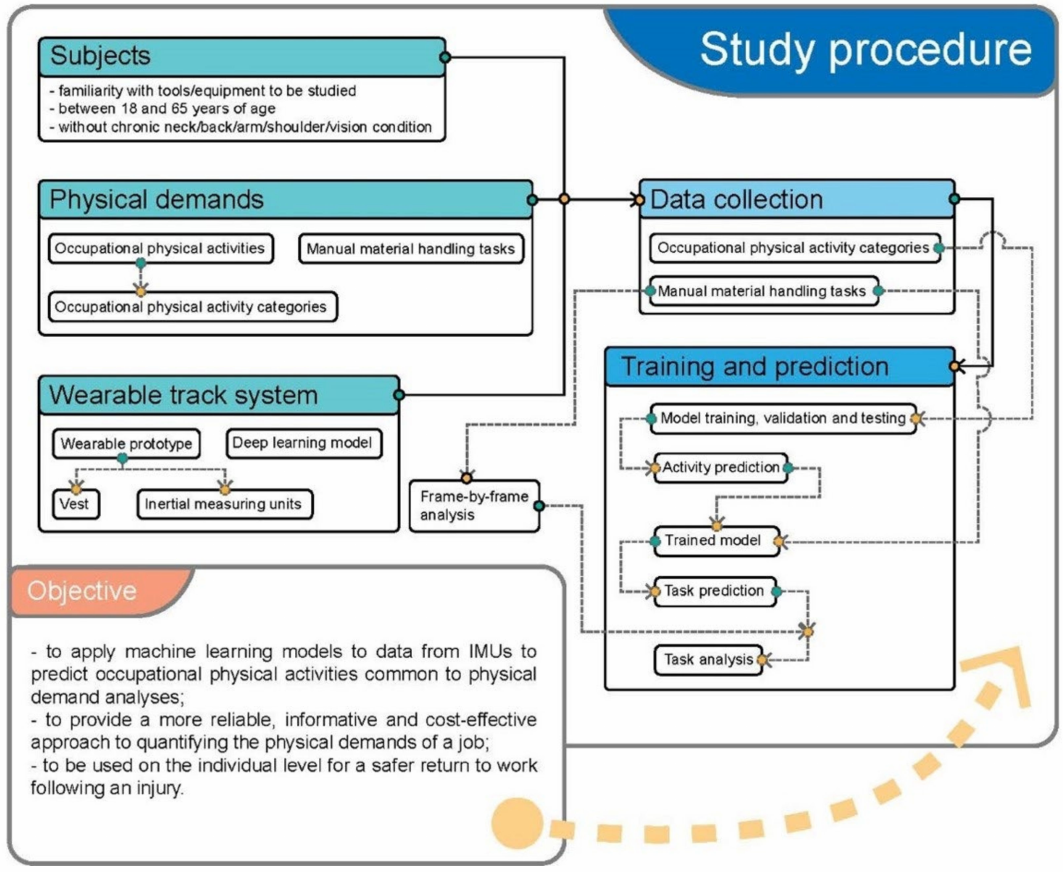
Figure 1. Study procedure of prediction of occupational physical activities using inertial measuring units and deep learning